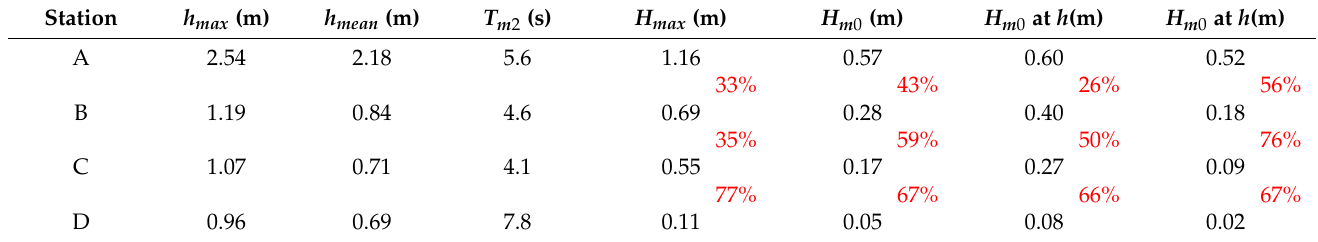
Table 3. Characteristic wave parameters for the measured stations for water depth h > 0.4 m, corresponding to time period from 10:30 to 16:30, 16 September. The subscript max, mean, and min indicate the maximum, mean and minimum value. T m 2 is the mean wave period. H m 0 is the significant wave height. The attenuation rate over 100 m (Equation (5)) was added between two adjacent stations and labeled by the ratios in red